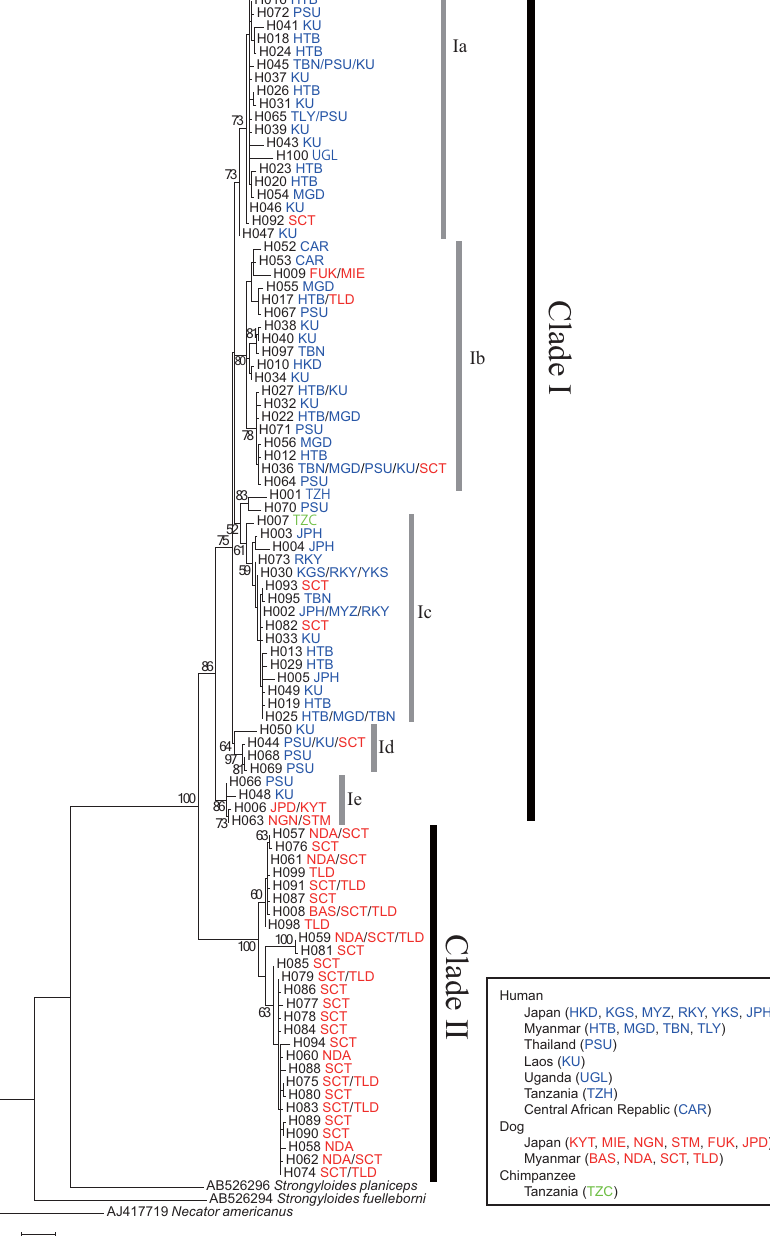
Figure 1. Maximum-likelihood tree built for Strongyloides isolates using a portion of the mitochondrial Cox1 gene. MEGA7 software was used to build the tree using a dataset of Cox1 (710 bp) gene haplotypes based on the Tamura-Nei model. Two/Three-letter codes next to the haplotype number indicate haplotypes from the respective hosts. Numbers at nodes indicate percent bootstrap values generated from 500 replicates. Scale bar denotes 0.02 changes per nucleotide